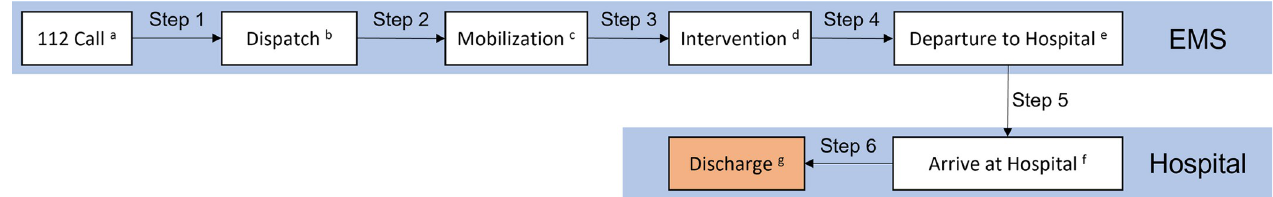
PLOS ONE | https://doi.org/10.1371/journal.pone.0275831 October 10,